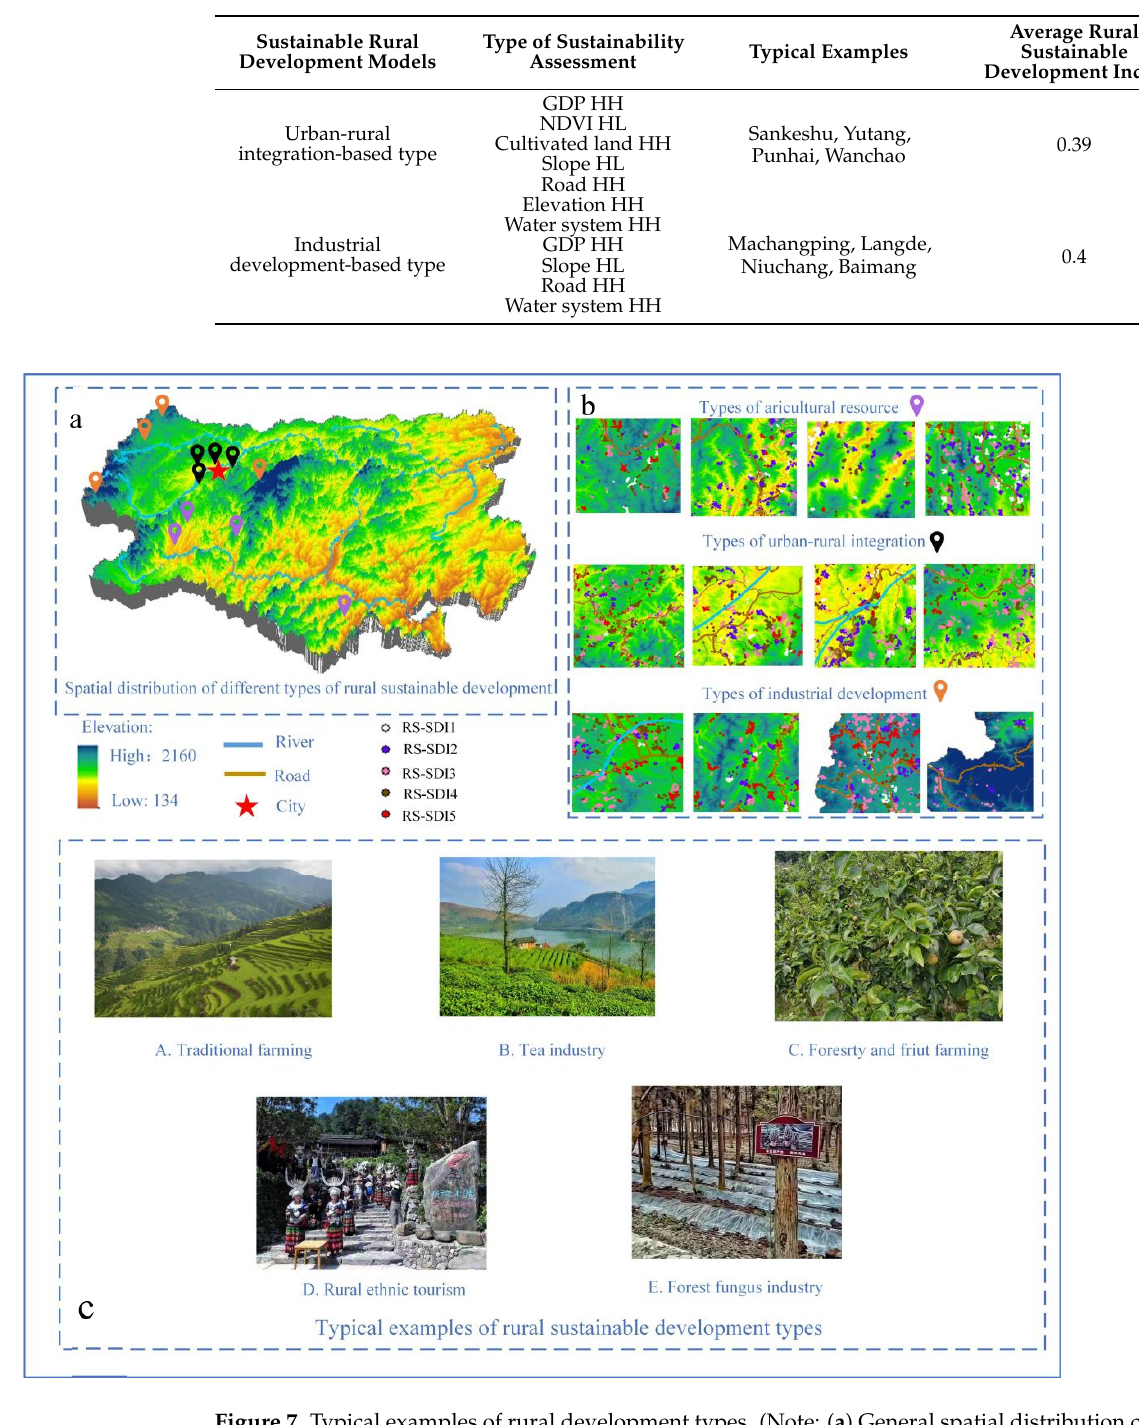
Figure 7. Typical examples of rural development types. (Note: ( a ) General spatial distribution characteristics of different rural sustainable development types; ( b ) Types of sustainable rural development; ( c ) Example map of rural development types.)